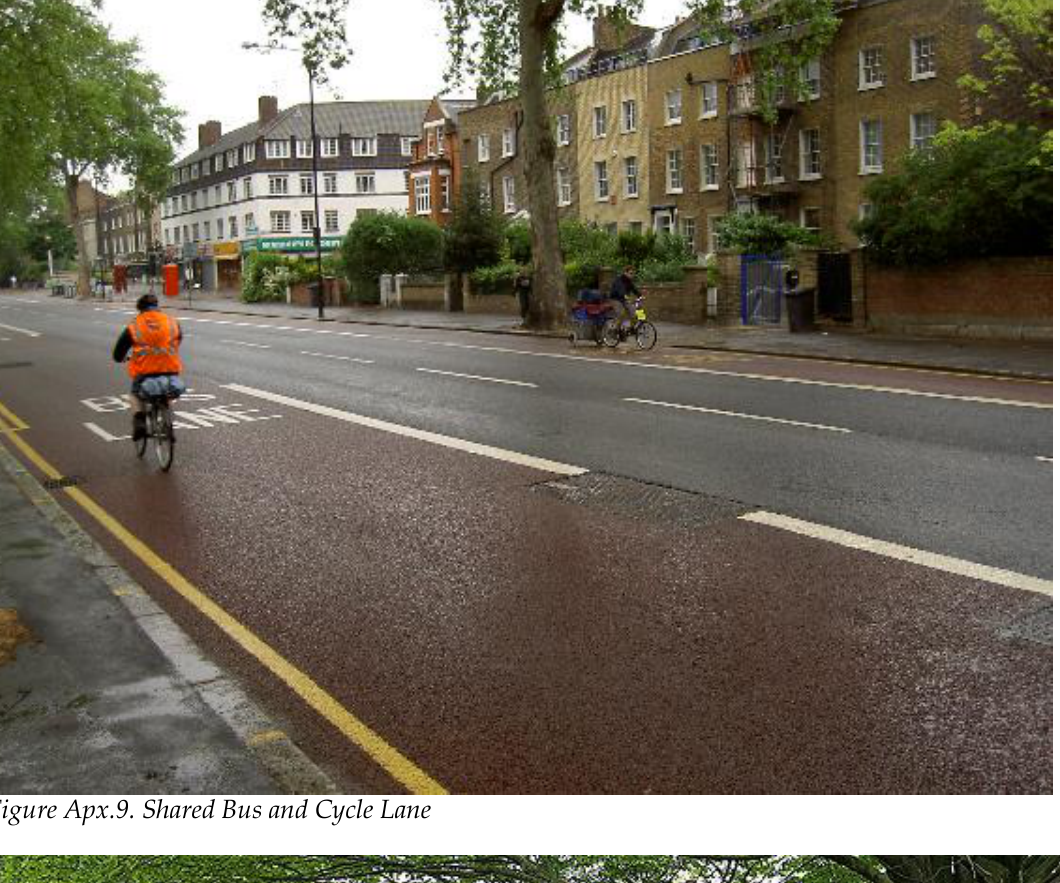
Figure Apx.9. Shared Bus and Cycle Lane